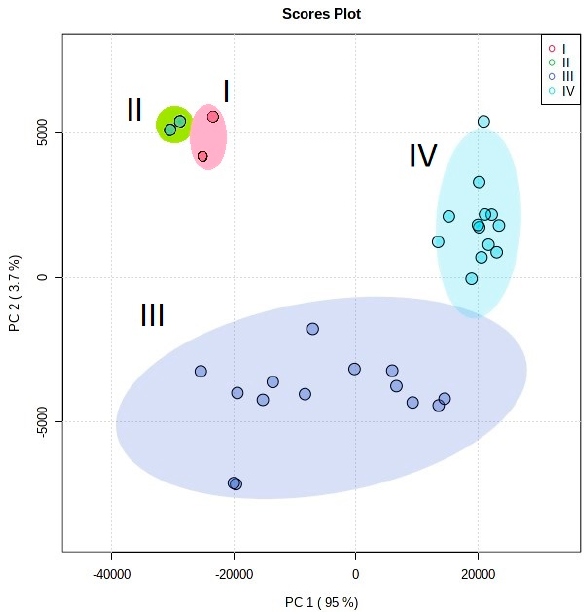
Figure 8. Results of PC analysis of the trace elements in biodeposits on the surface of stone: